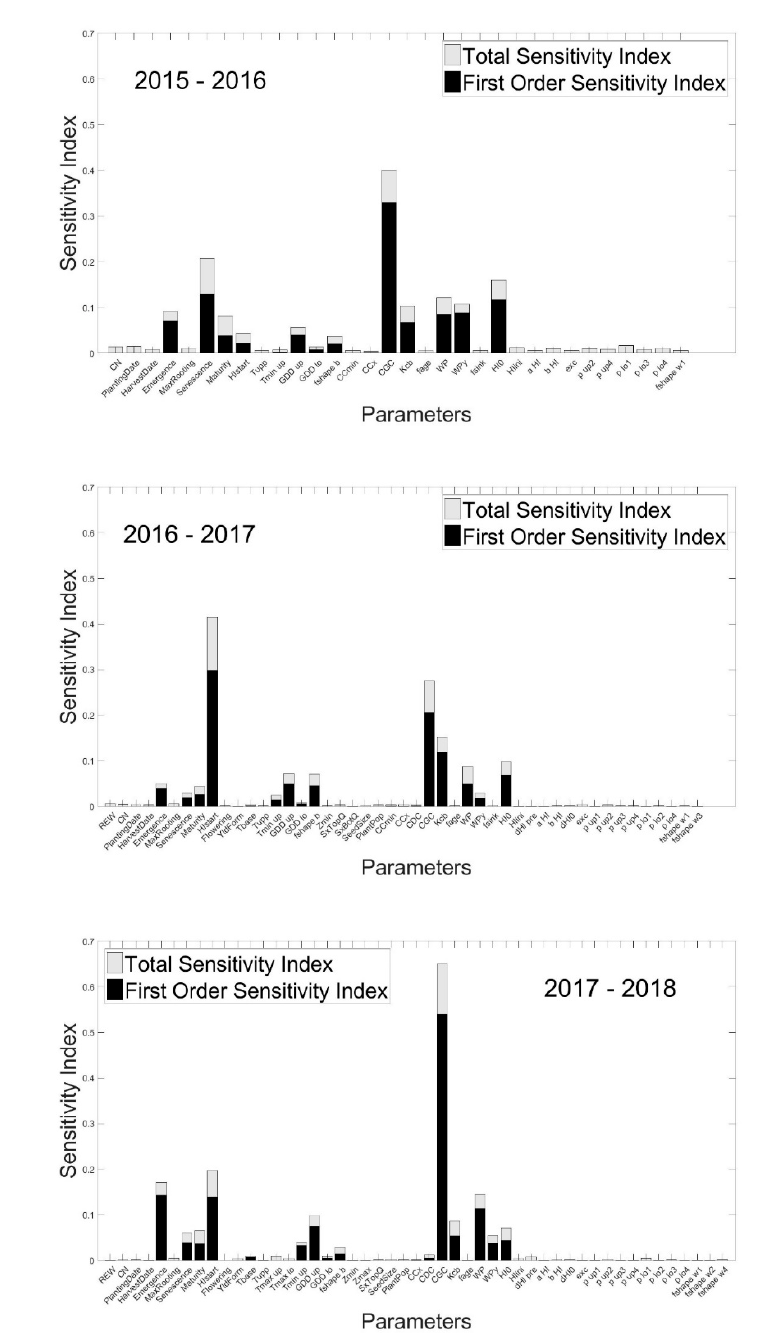
Figure 3. First-order and total-order SI for different years for Maccarese. Only the parameters with a total sensitivity index higher than the sensitivity index of the dummy parameter are shown. The details on the parameters can be found in Table 1.